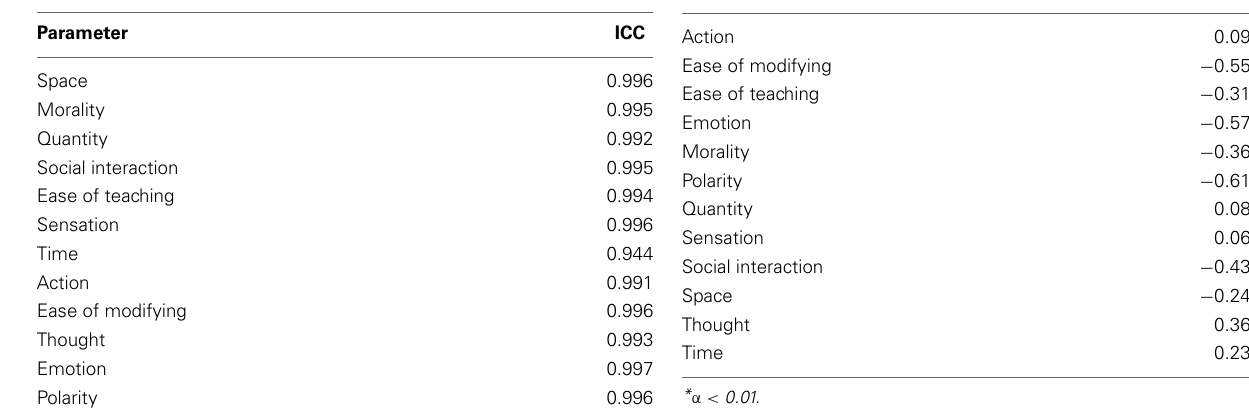
each target word. All of the bivariate correlations were significant ( α ≤ 0 . 01).